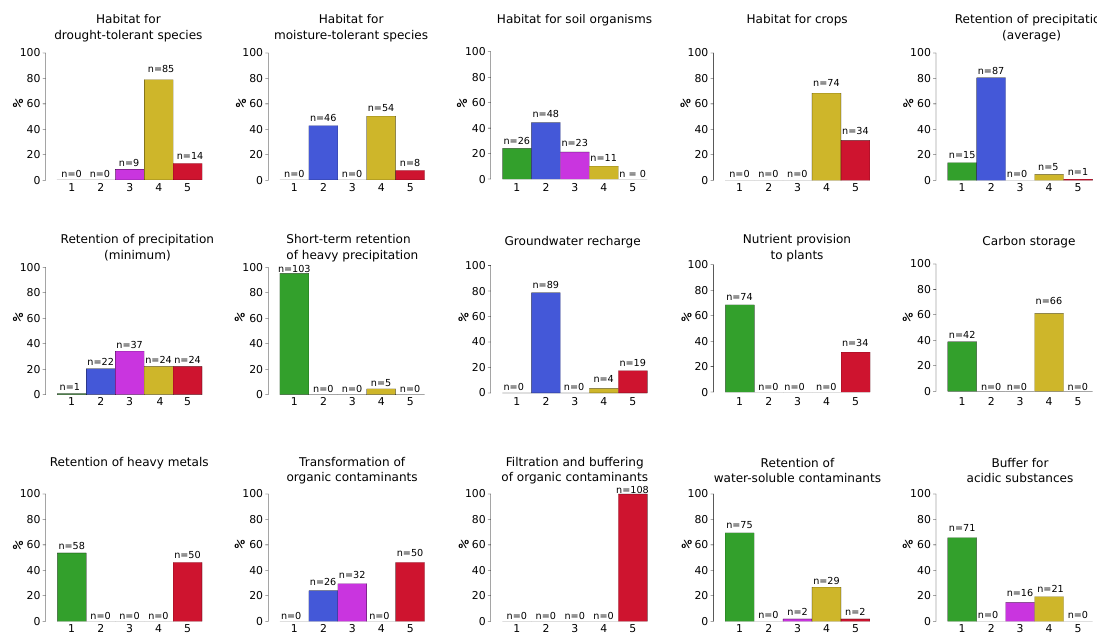
Figure 5. Barplots representing the distribution of the soil function fulfillment levels of the 108 soil profiles as predicted by a SVM classifer based on the selected features presented in Table